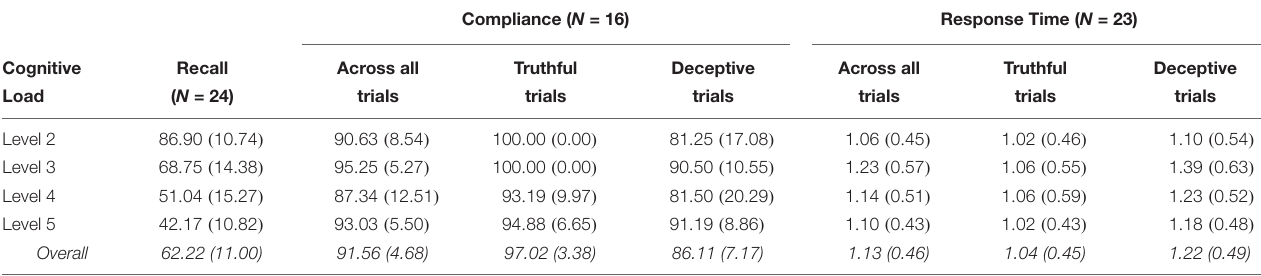
TABLE 2 | Means (Standard Deviations) for recall, compliance, and response time under different levels of cognitive load in the sham condition. Compliance ( N =